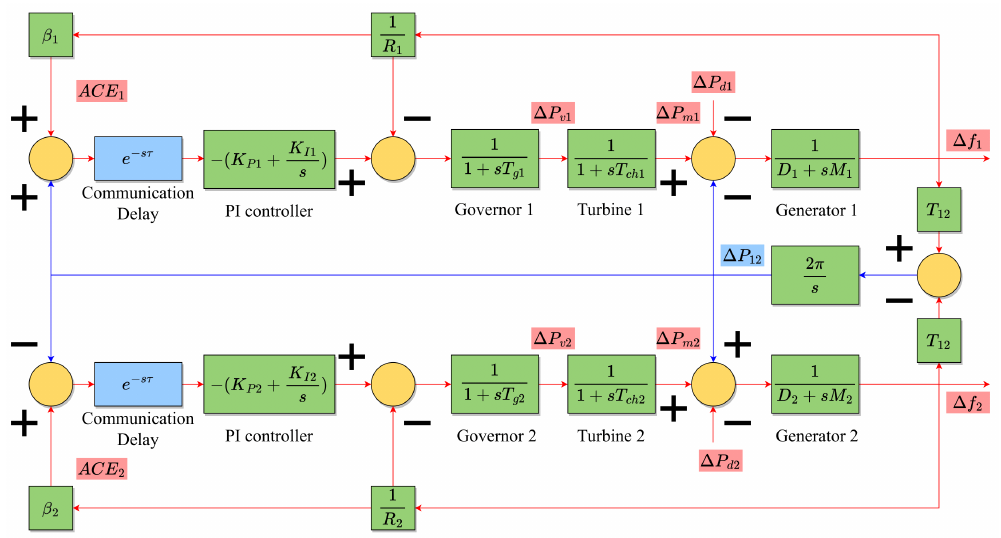
Figure 1. Two-area LFC scheme